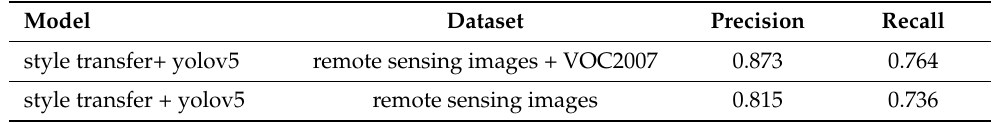
Table 7. Detection result with two